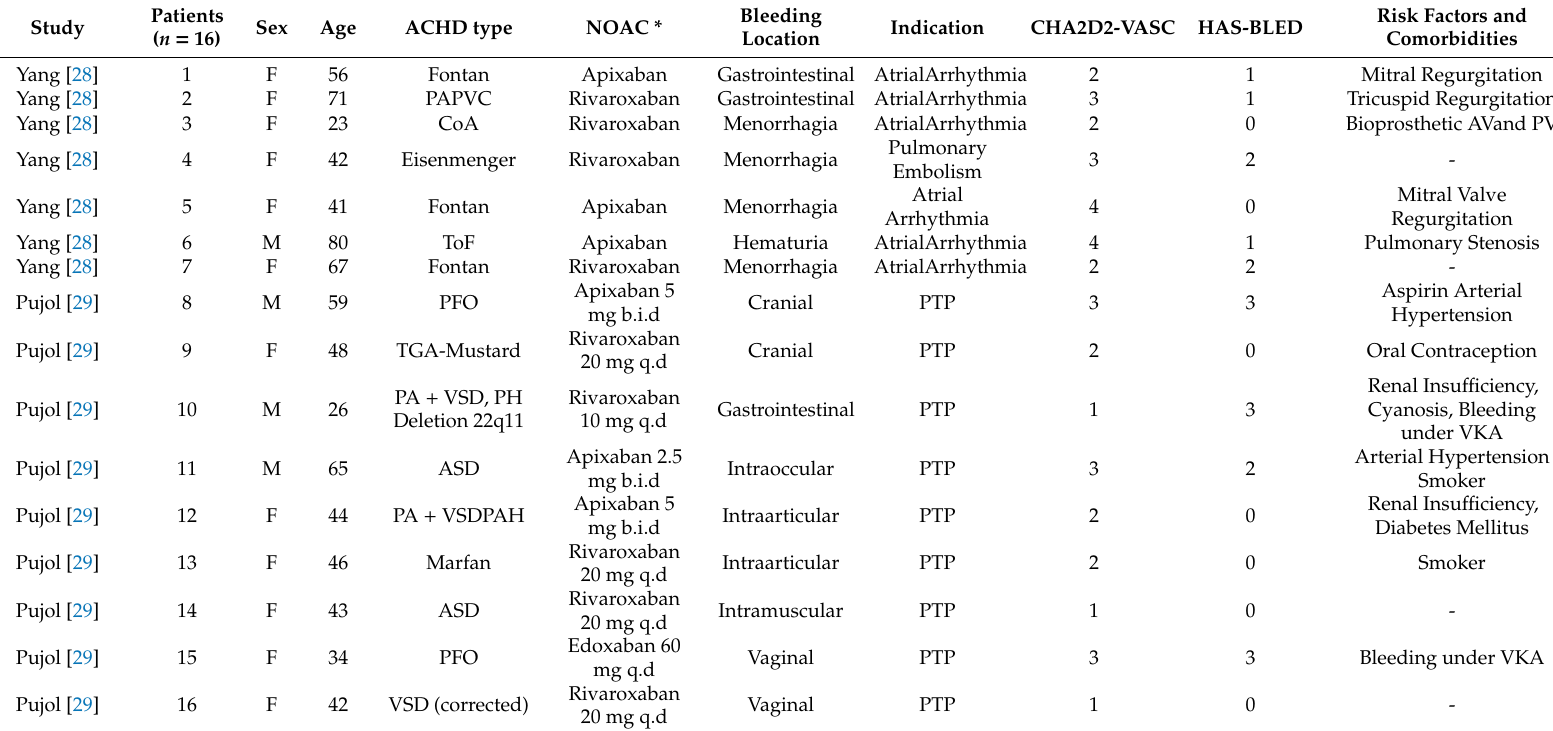
Table 6. Descriptive characteristics of patients with major bleeding